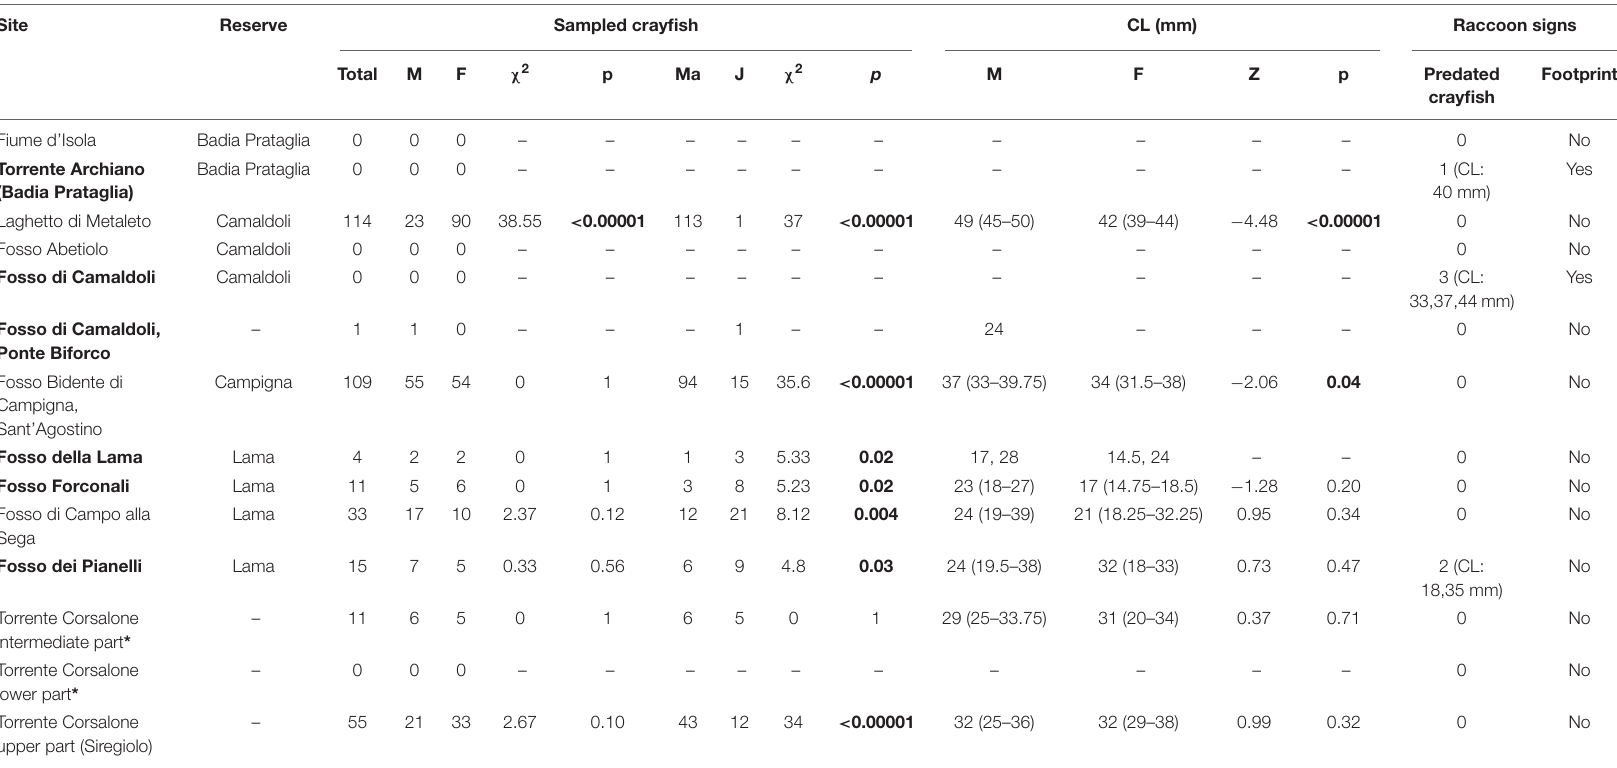
TABLE 1 | Number, sex (M, male; F, female) and cephalothorax length (CL) in mm of sampled crayfish, the presence of raccoon signs, and the confirmed presence of raccoon per site.